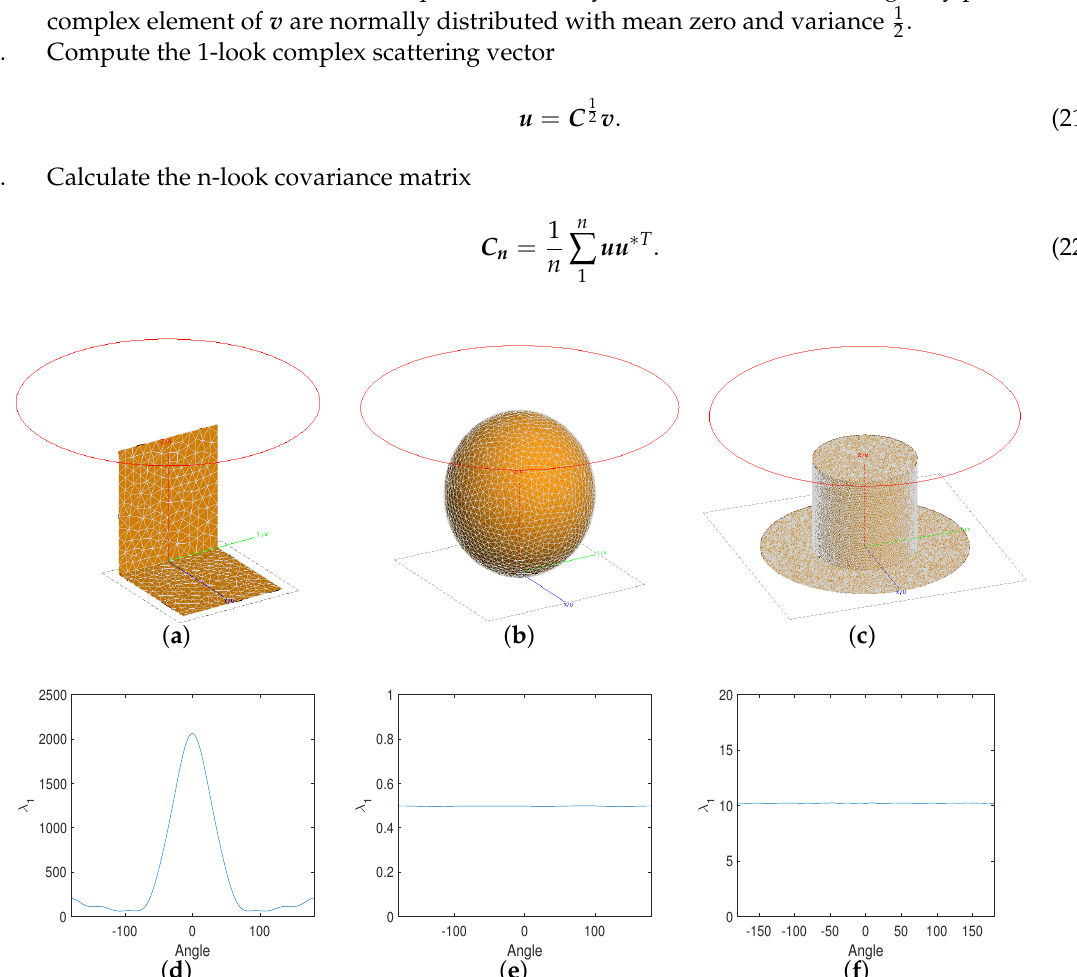
Figure 5. The structure of: ( a ) dihedral; ( b ) sphere; and ( c ) tophat; together with variations of λ 1 across angles of view of: ( d ) dihedral; ( e ) sphere; and ( f )